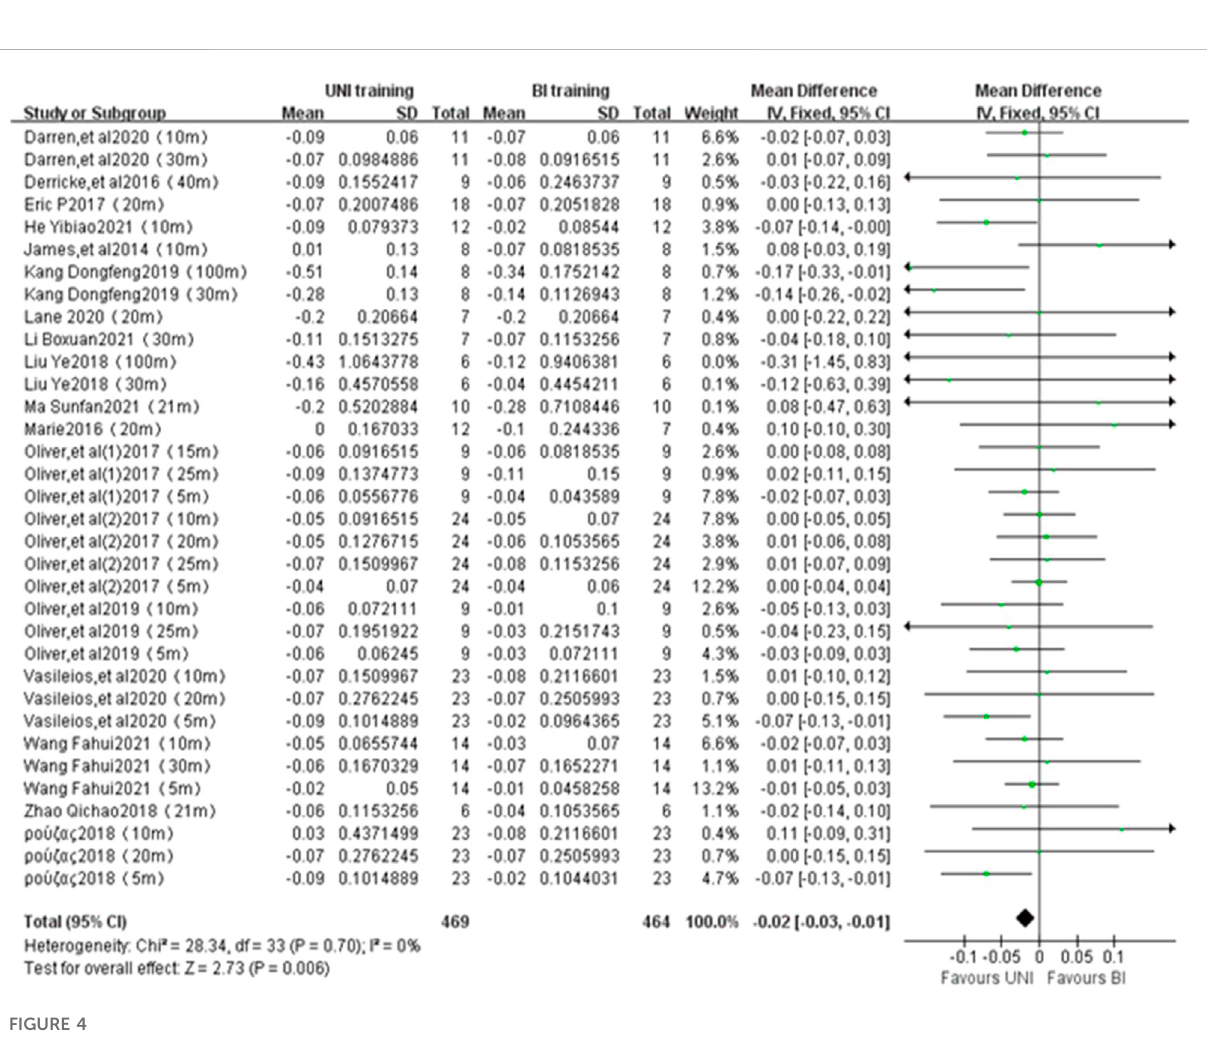
FIGURE 4 Intergroup Forest plots of UNI and BI training affecting sprinting